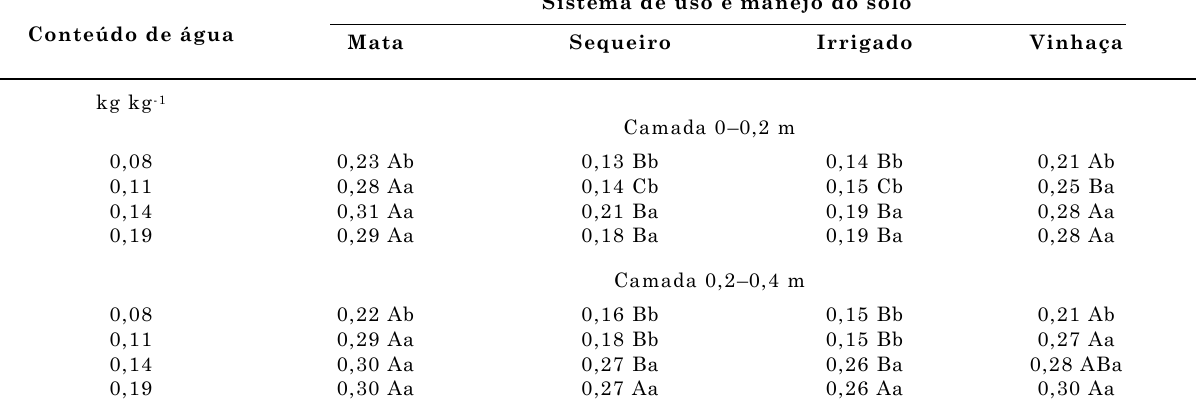
= 50 kPa; Ug = 0,19 kg kg -1 (b) σσσσσ n